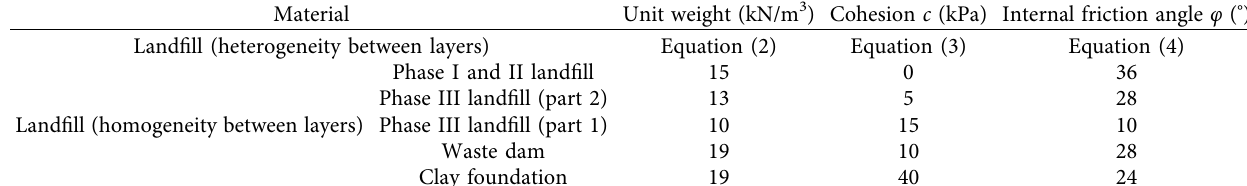
Table 3: Reference values for engineering properties of the landfill.